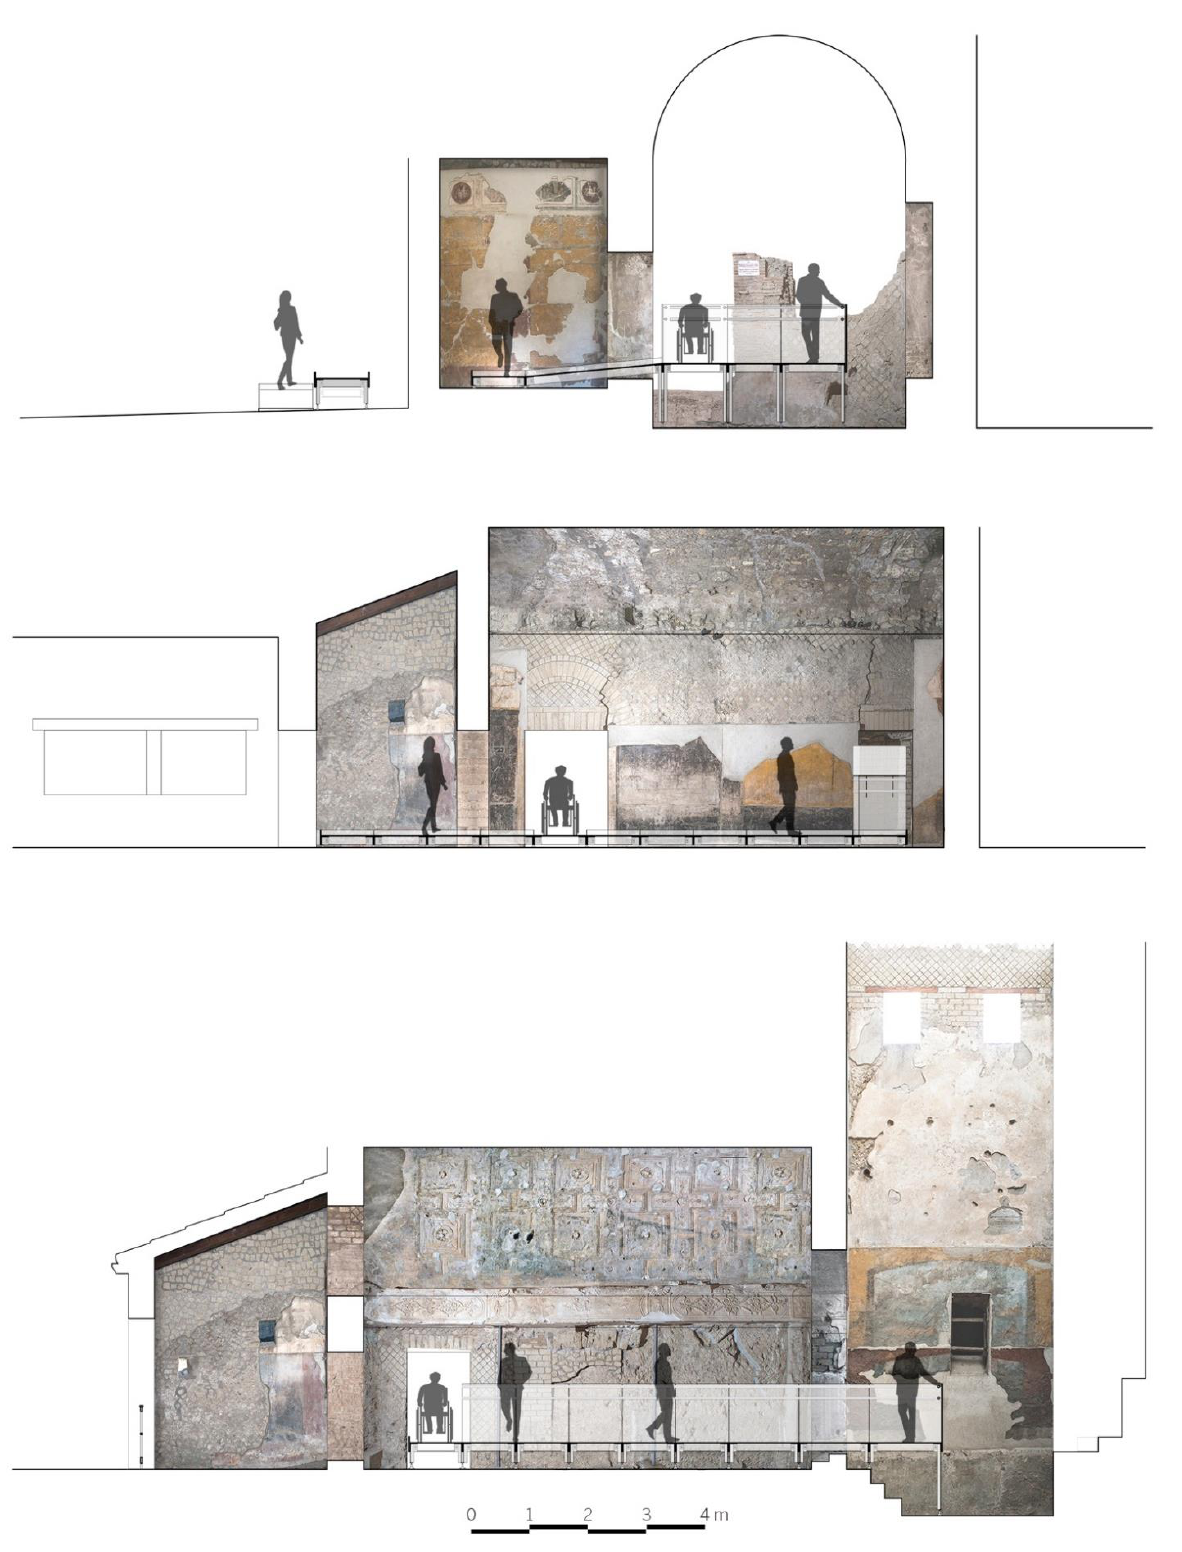
Figures 7, 8 and 9. Internal sections of the project for an improved fruition of the Suburban Thermal Baths in Pompeii, with the walkway in structural glass. From the top: natatio , apotyderium, frigidarium. (The research “Pompeii becomes accessible: a study of the accessibility to Pompeii archeological site through the entrance of the suburban Thermal Baths and the connection with the Antiquarium” was conducted by professors and scholars of the University of Naples Federico II: Renata